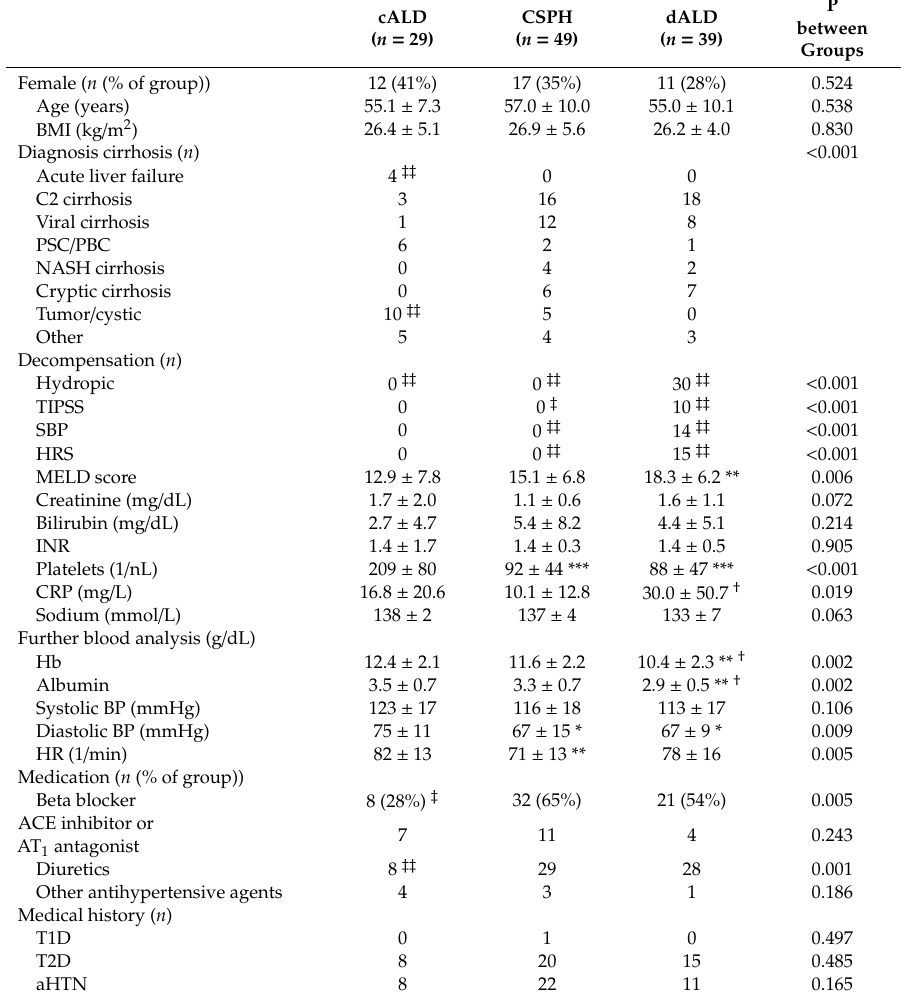
Table 1. Patient characteristics (mean +/ −